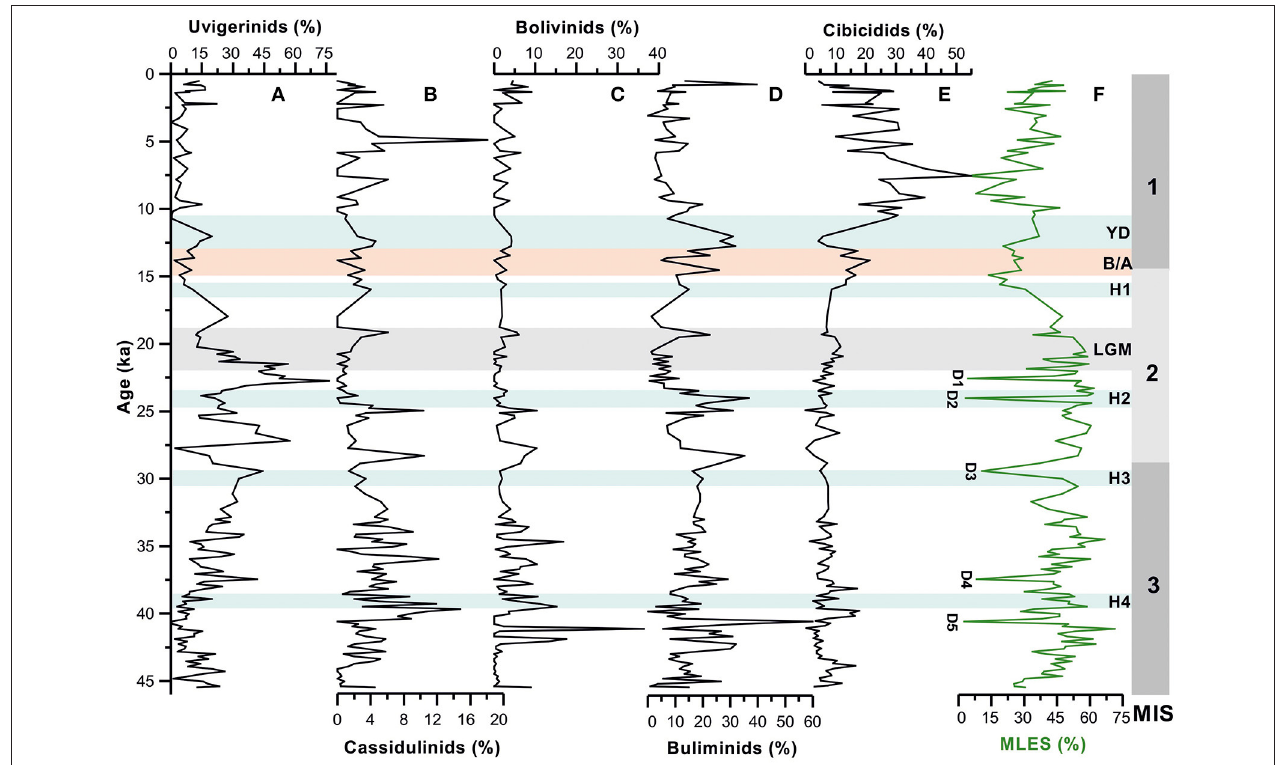
FIGURE 4 | Temporal variations in relative abundances of major benthic foraminiferal groups [ (A) uvigerinids, (B) cassidulinids, (C) bolivinids, (D) buliminids, and (E) cibicidids] compared with (F) Mixed layer eutrophic species (MLES) abundance record (surface productivity proxy). D1–D5 represents possible dissolution points following Verma et al. (under revision) 1 . MIS 1–3 denotes the Marine Isotope Stages; H1–H4, Heinrich Events; YD, Younger Dryas; B/A, Bølling/Allerød; LGM, Last Glacial